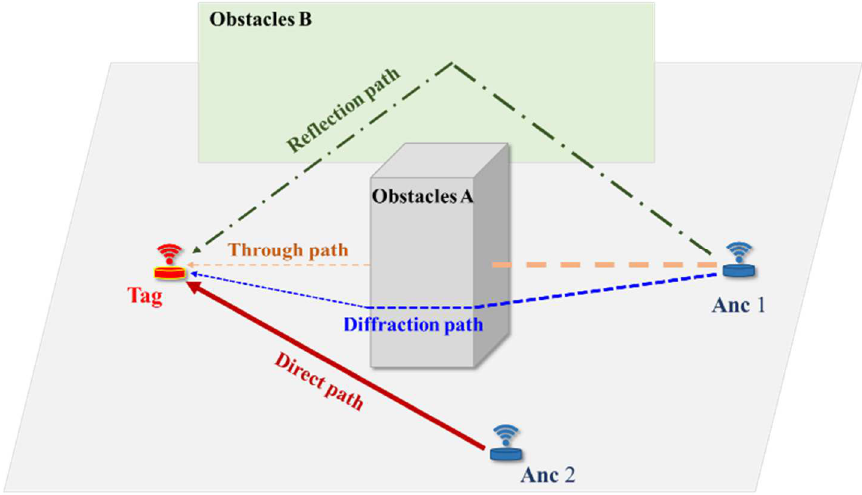
Figure 1. Schematic diagram of LOS and NLOS propagation of UWB signals.